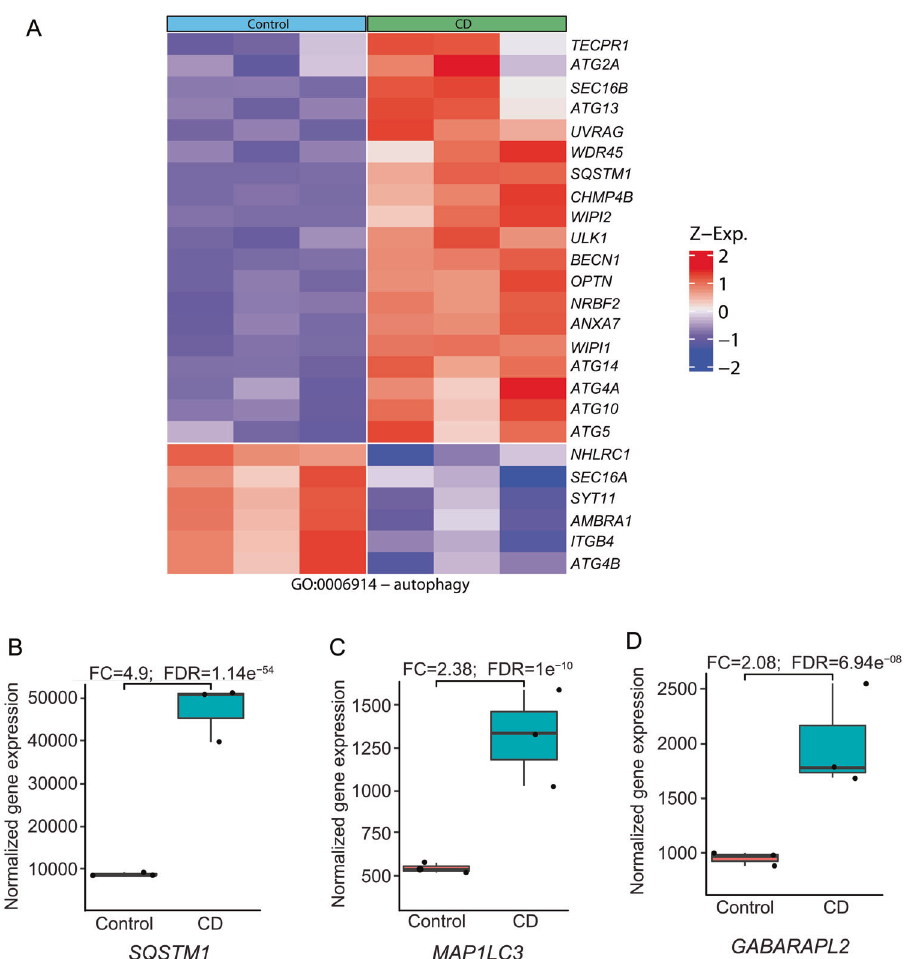
Fig. 2 Cholesterol depletion increases the mRNA levels of multiple autophagy-related genes. RNA-seq of Mv1Lu cells was as in Fig. 1. A Heat map of differentially expressed genes related to autophagy. Only those genes with signi fi cant differential expression (FDR < 0.05) are shown. B – D Box plot of three speci fi c autophagy-related genes whose expression was signi fi cantly enhanced by CD: SQSTM1 , which encodes p62 ( B ), MAP1LC3 , encoding LC3 ( C ), and GABARAPL2 , which encodes GEF-2 ( D ). The fold change (FC) and FDR-adjusted P -values are